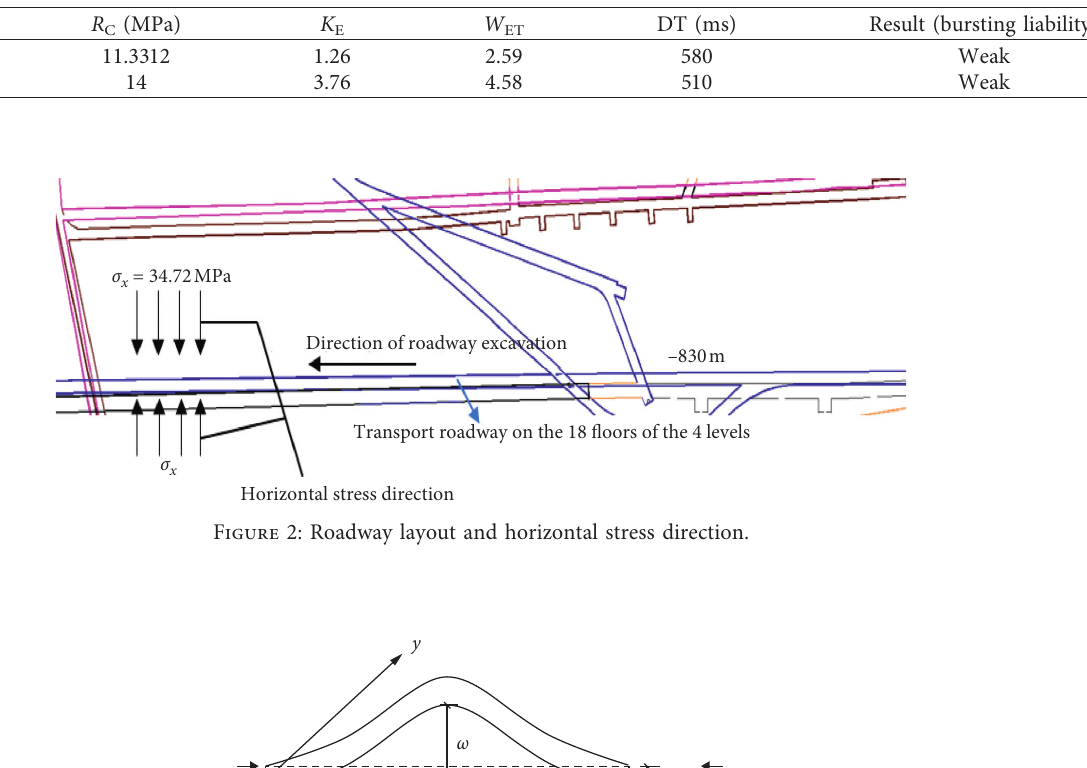
Table 1: Bursting liability of coal sample.